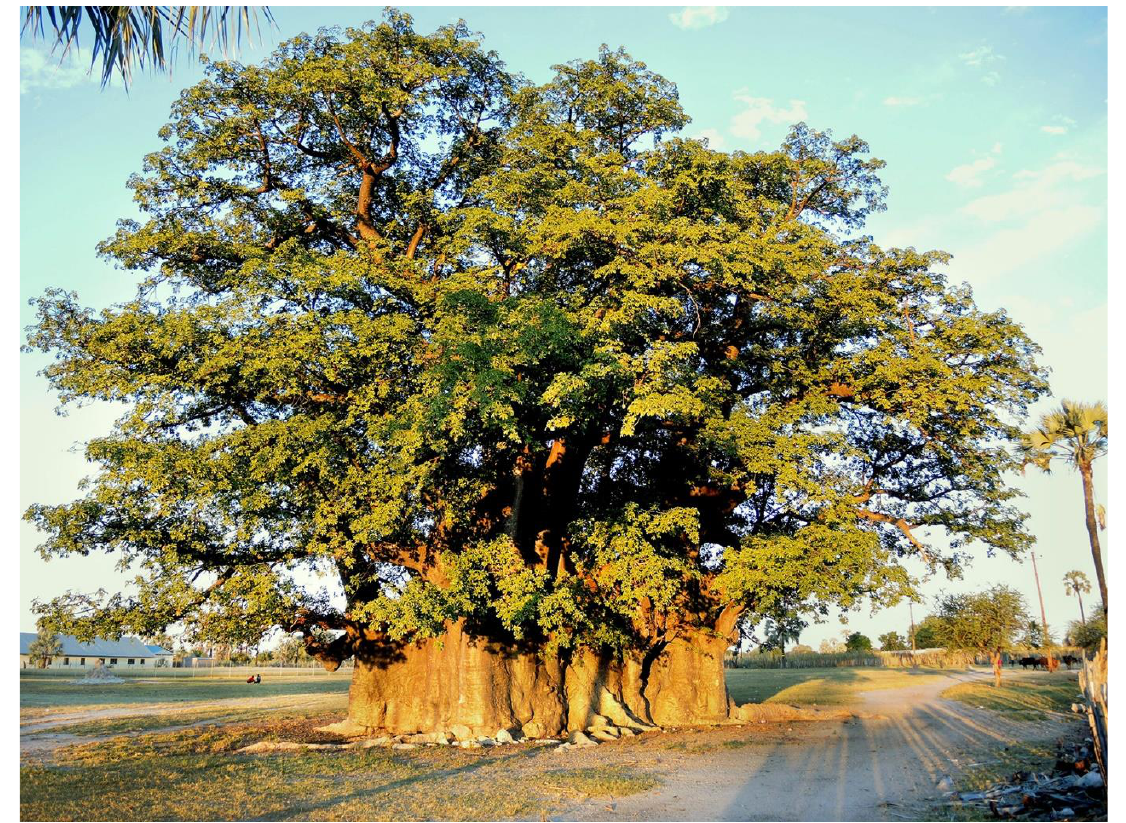
Figure 10. General view of Sir Howard baobab taken from the south.